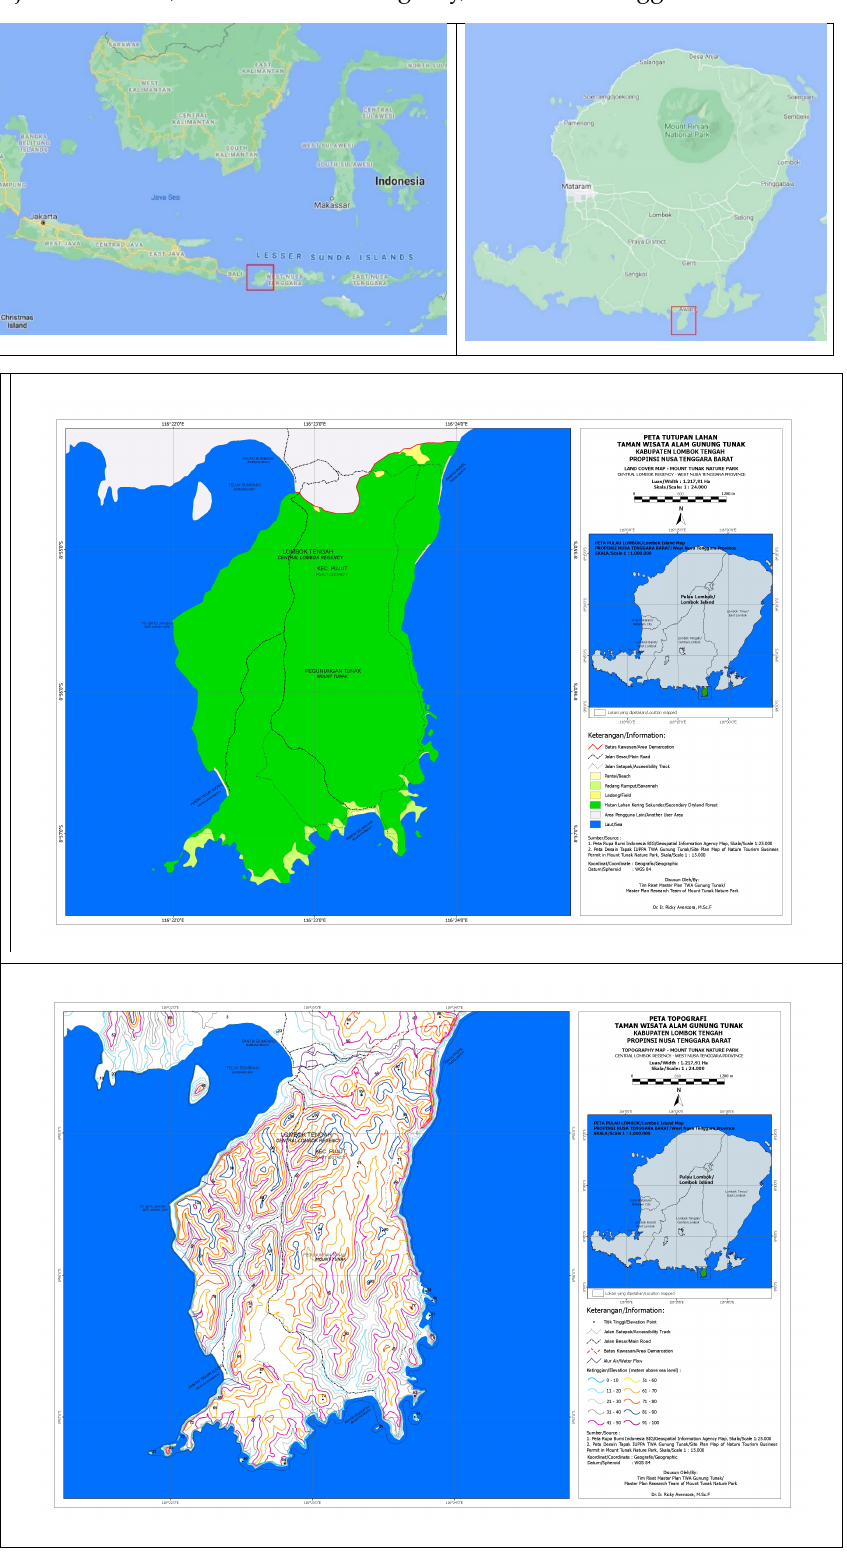
Figure 1. Map of Gunung Tunak, Lombok, Nature Recreation Park, Indonesia (Source: Google Maps, Geospatial Infor- mation Agency, IUPPA TWA Gunung Tunak).